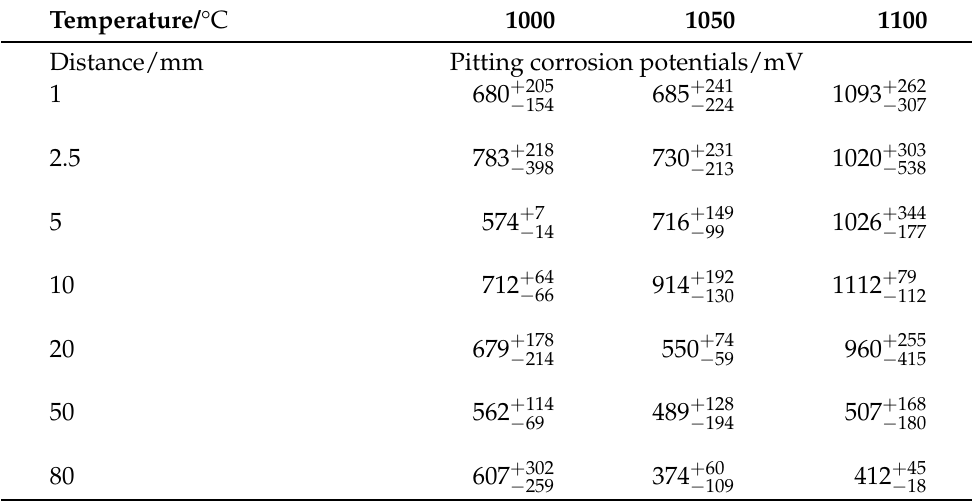
Table 9. Pitting corrosion potentials Ag/AgCl (3mol